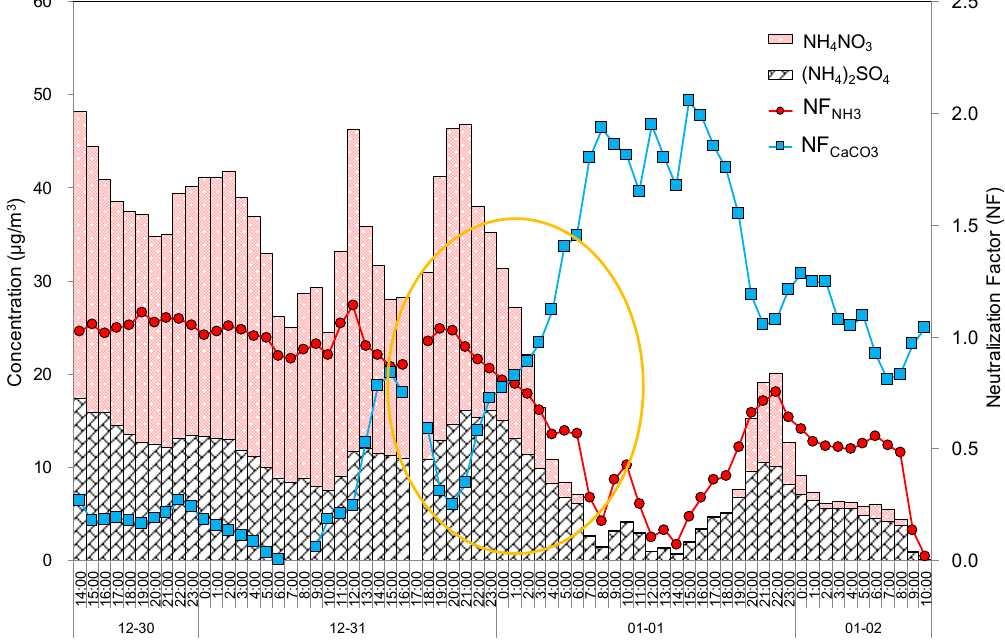
Figure 6. Time series variations of 1 h averaged estimated concentrations of (NH 4 ) 2 SO 4 and NH 4 NO 3 and neutralization factors by NH 3 and CaCO 3 during the high concentration episode.